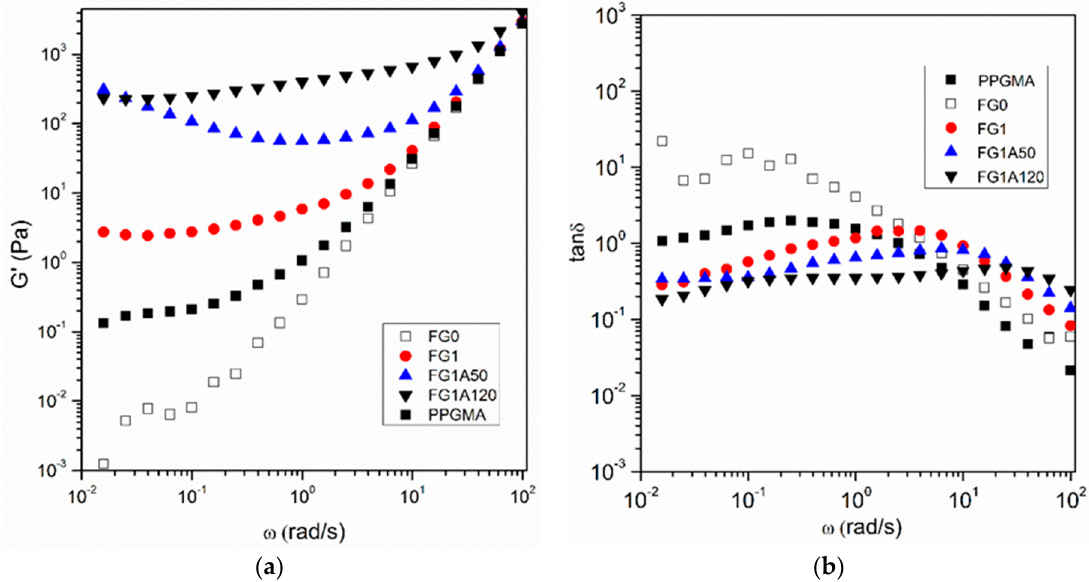
Figure 9. Storage (G’) modulus ( a ) and loss tangent (tan δ ) ( b ) of PPgMA and its derivatives at various angular frequency ( ω , rad/s) and measured at temperature of 160 °C.